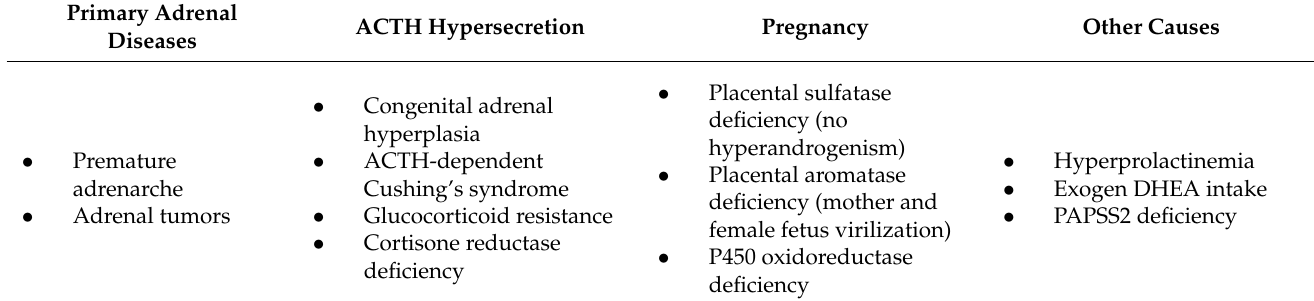
Table 1. Adrenal Originated Androgen Excess